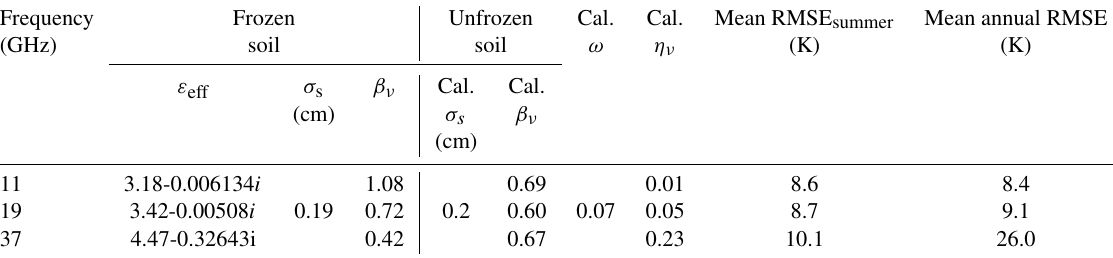
Table 4. Effective parameters calibrated for the 12 studied sites to quantify soil contributions e surf (calibrated surface roughness “cal. σ s ” and calibrated polarization ratio “cal. β ν ”) and vegetation contributions (controlled by the calibrated ( ω , η ν ) parameters “cal. ω ” and “cal. η ν ” according to the daily LAI) measured at the top of the atmosphere. The parameterization of frozen ground was estimated by Montpetit et al. (2018). ε eff is the effective dielectric constant estimated with the permittivity of frozen and unfrozen soils derived from Dobson’s equations (1985). Annual and seasonal T BTOA RMSEs estimated for the summer and the winter period (RMSE summer and RMSE winter ) are calculated from 2012 to 2016 with the calibrated parameters. Frequency Frozen Unfrozen Cal. Cal. Mean RMSE summer Mean annual RMSE